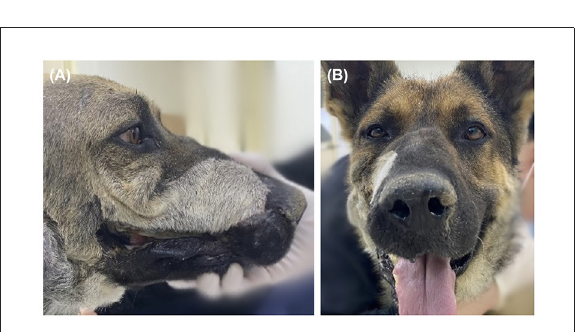
FIGURE6 Evaluation of the cosmesis of the reconstruction 6 months after PSI application. Except for the hair color and direction change resulted from angularis oris cutaneous flap seen on lateral view (A) , facial symmetry was perfect on front view (B) .